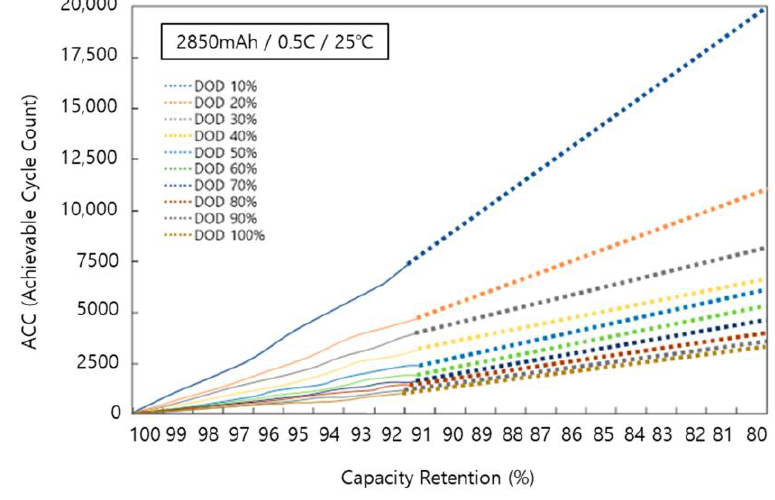
Figure 6. ACC life test by capacity retention.